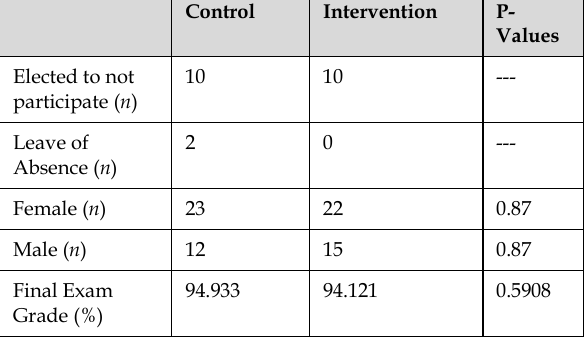
Table 1 Characteristics of